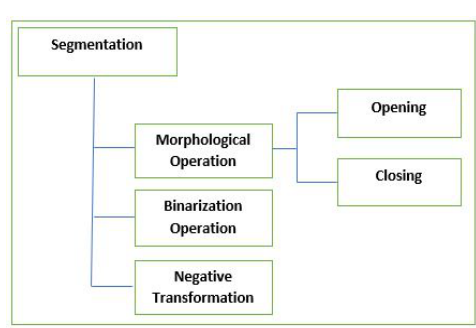
Figure 5. Result of the Image enhancement operations